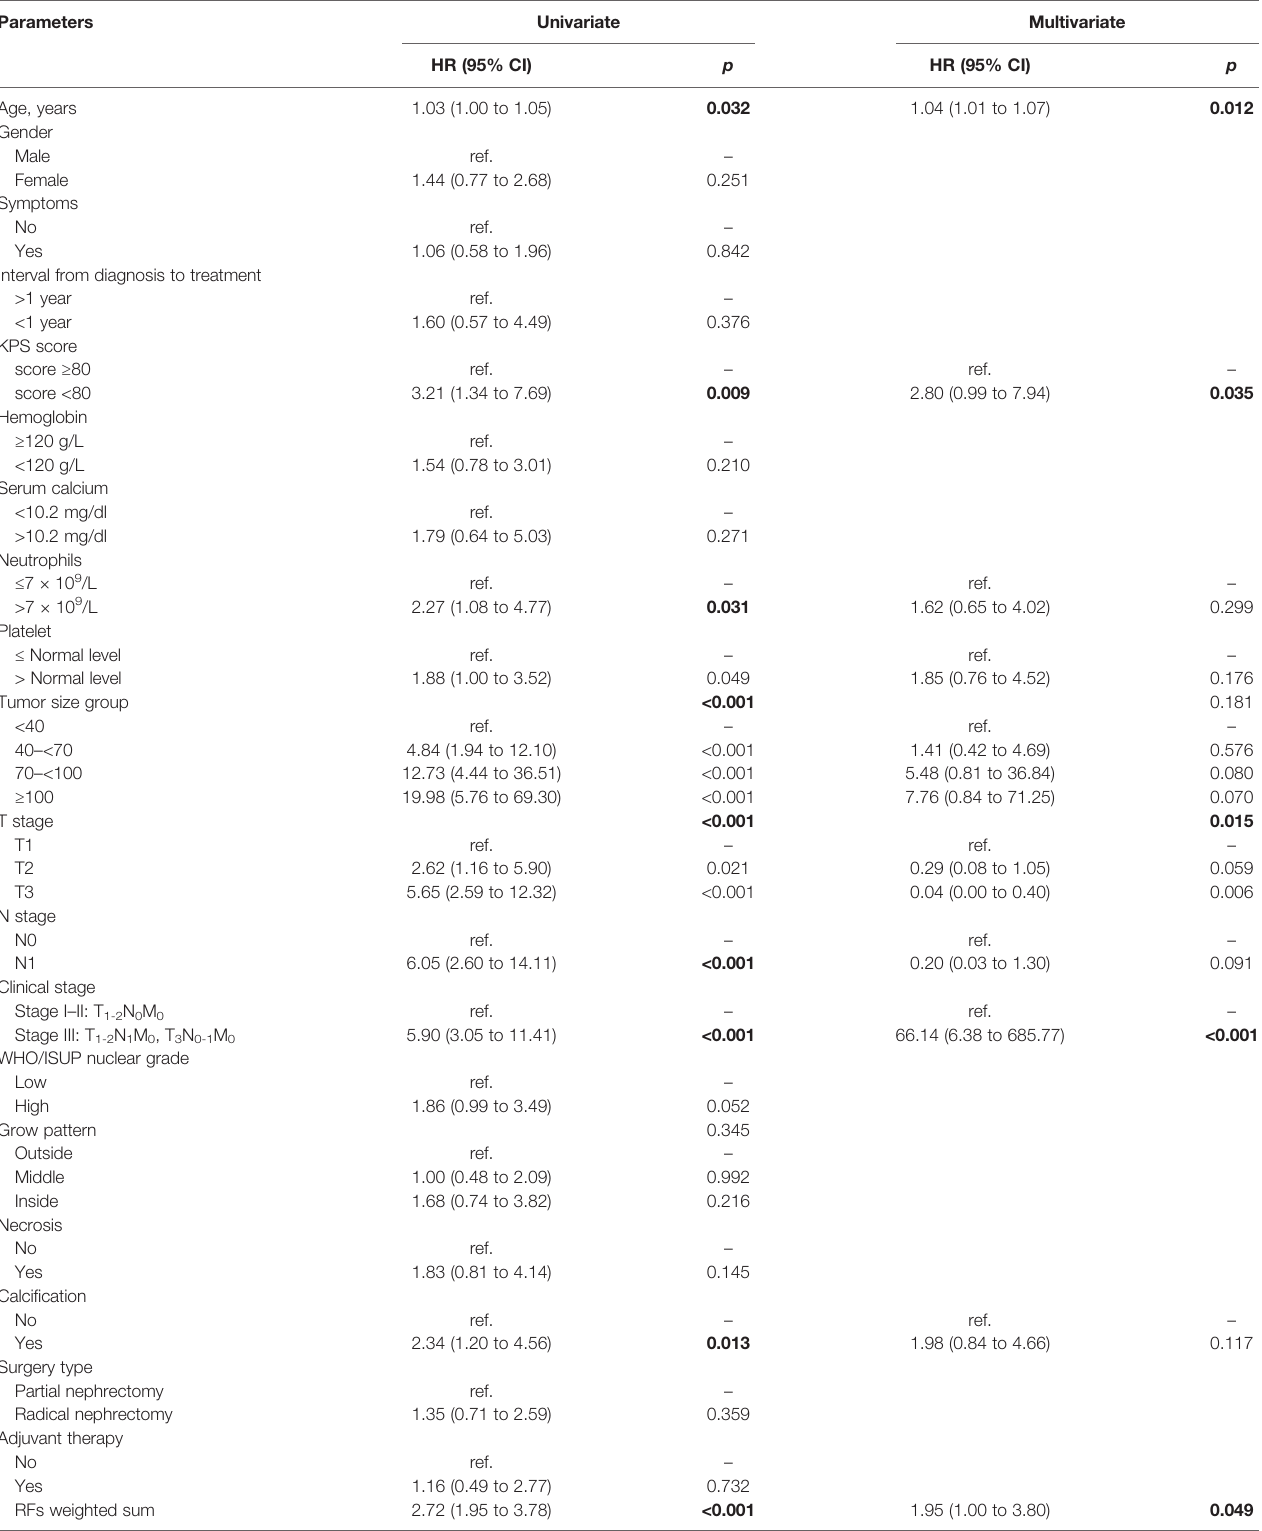
TABLE 3 | Univariate and Multivariate Cox-regression results in training